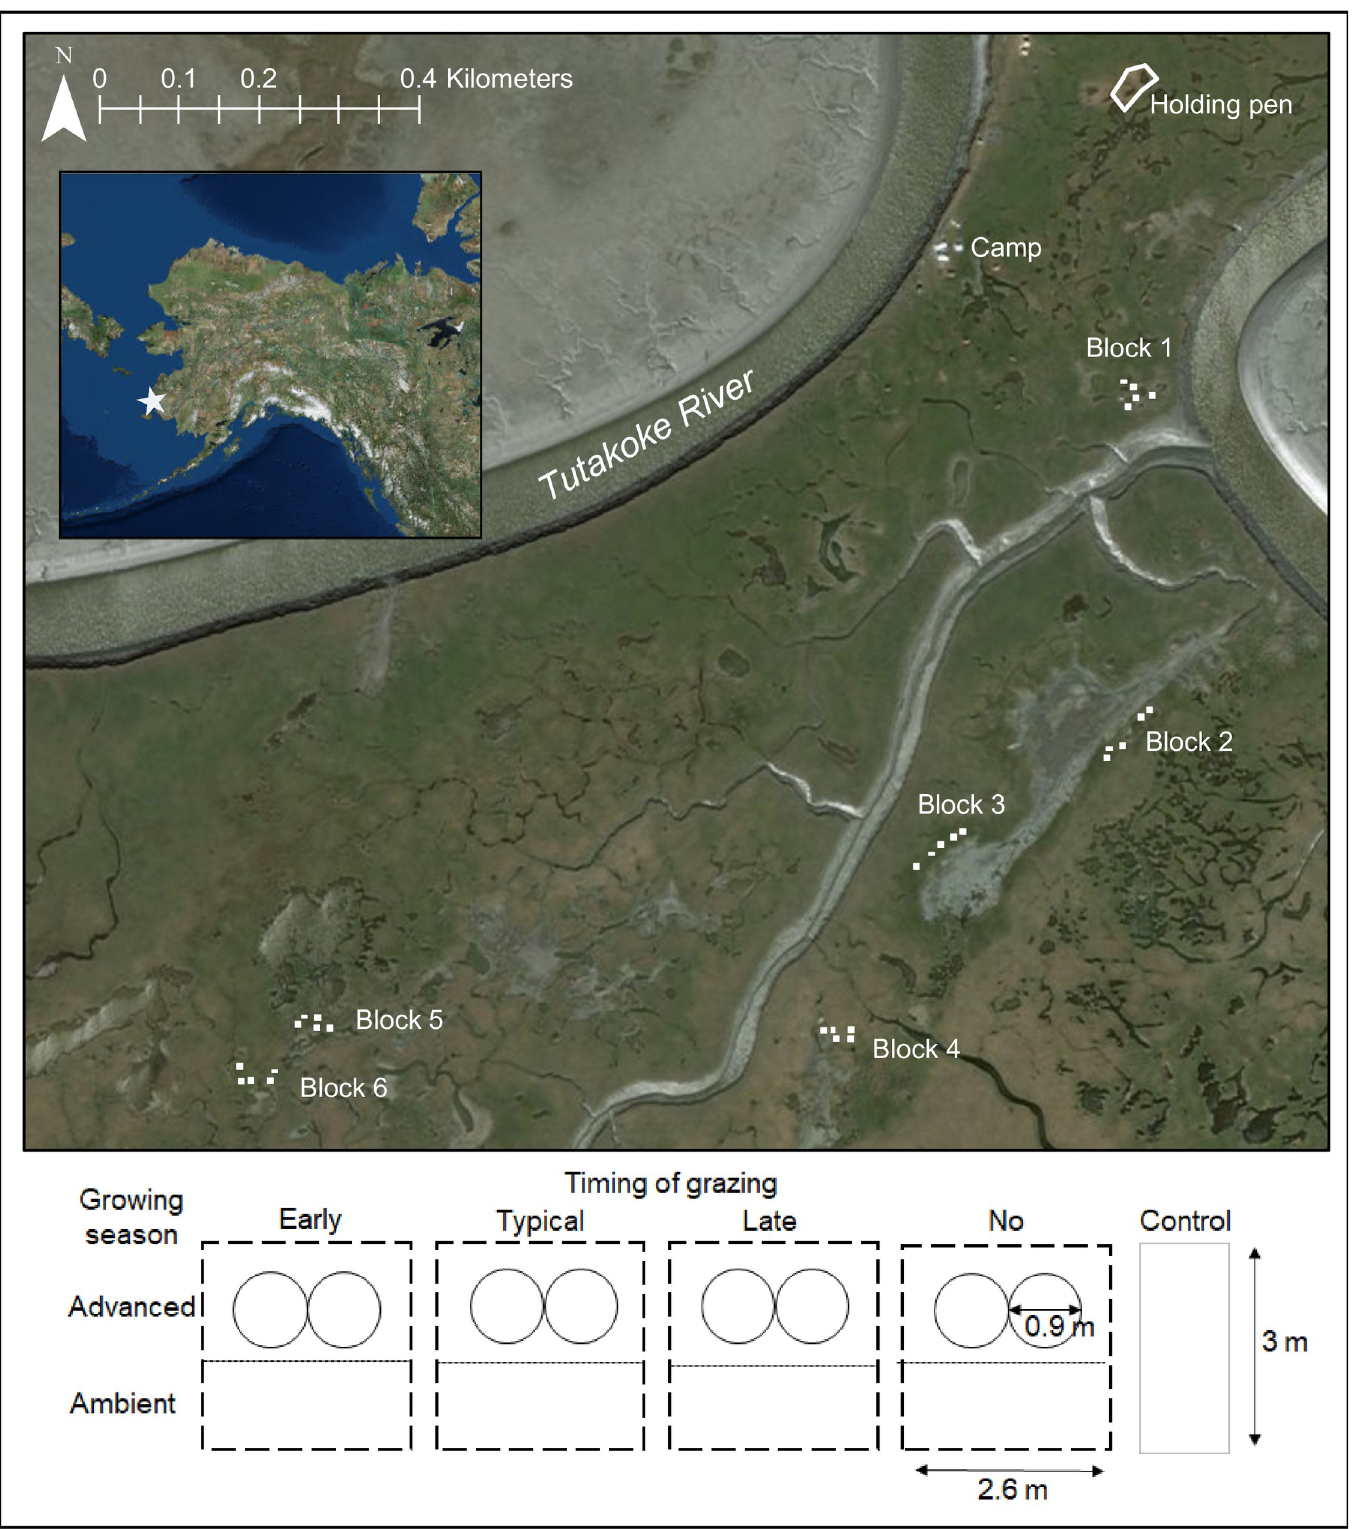
Fig 2. Experimental design. Image of the study site showing where the six blocks with the nine experimental treatments and the holding pen for geese were located. The bottom panel illustrates how the timing of grazing plots were placed together and fenced for the controlled grazing treatments. Created with ESRI ArcGIS 10.6.1 software. Basemap data sources include: Esri, DigitalGlobe, GeoEye, i-cubed, USDA, USGS, AEX, Getmapping, Aerogrid, IGN, IGP, swisstopo, and the GIS User Community.